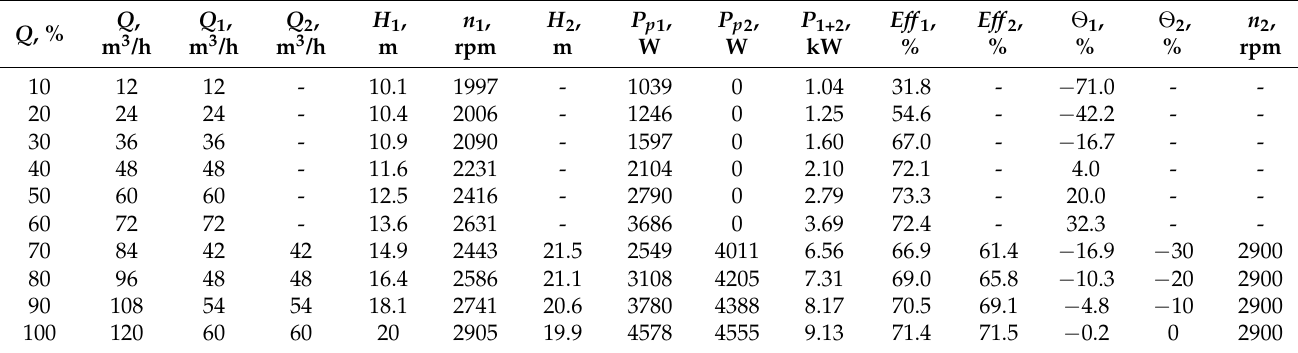
Table 2. Pump system performances applying the minimum energy consumption